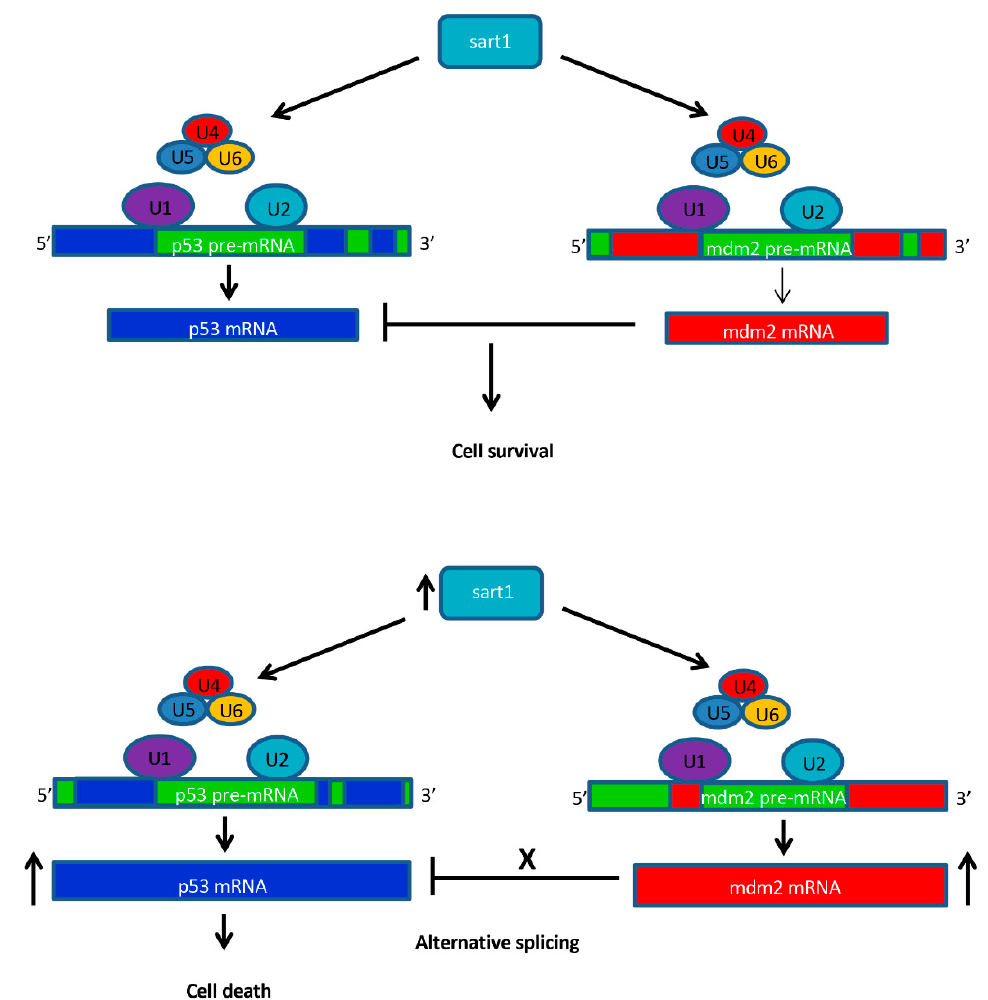
Figure 10. Schematic diagram for the hypothetical role of Sart1 in apoptosis. In wild-type, Sart1 acts to recruit the U4/U6.U5 tri-snRNP to the spliceosome complex where U1 and U2 are already bound to pre-mRNA at the 5 ′ splice site and branch point site, respectively. Once the spliceosome is assembled, it processes pre-mRNA by removing introns and producing mature mRNA transcripts for genes such as tp53 and mdm2 . Mdm2 inhibits p53 allowing for cell survival of photoreceptors. In mutants, while the S art1 transcript is upregulated, altered Sart1 protein may result in defective recruitment of U4/U6.U5 to the spliceosome thereby causing alternative splicing of p53 and mdm2 . Alternative splicing may result in altered proteins such as Mdm2 which can no longer function to inhibit p53 activity. In addition, alternatively spliced tp53 transcripts may result in proteins that can no longer be inhibited by Mdm2. This phenomenon may lead to up-regulation of p53 and increased cell death in photoreceptors.